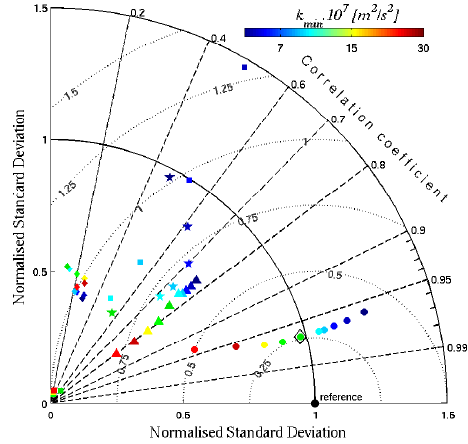
Fig. 2. Taylor diagram of the model sensitivity to the vertical turbu- lent exchange parameterisation (different values of k min are used). Model to reference statistics are presented for oxygen (denoted with circles ” • ”), phosphorus (denoted with triangles “ N ”), ammonium (asterisks “ ∗ ”), nitrate (diamonds “ (cid:7) ”) and chlorophyll a (squares “ (cid:4) ”) fields in the period 1998–2003 at BS. The colour bar repre- sents 10 different values of k min × 10 7 in the interval [5;30]. The minimum value of the RMSD for oxygen is indicated by black dia- mond (“ ♦ ”). The black circle at a correlation of 1.0 and normalised standard deviation of 1.0 represents the